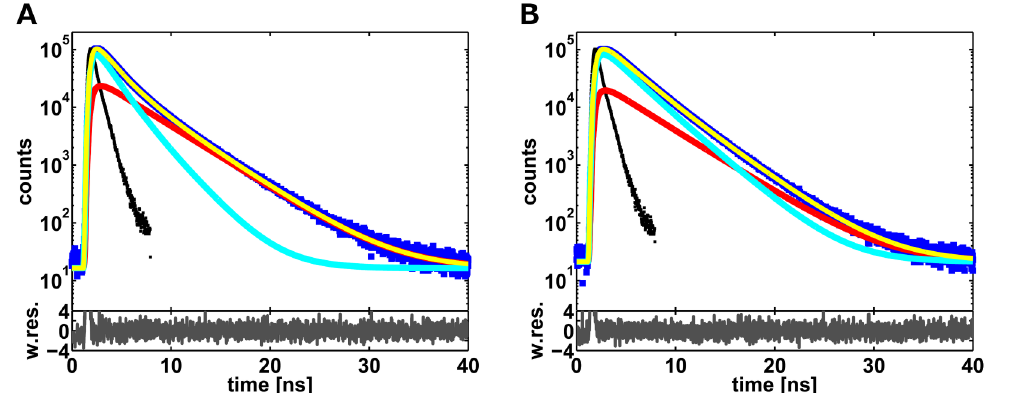
Figure 2. Donor ensemble lifetime decays and fitted model functions for: ( A ) 10 bp DNA and ( B ) 17 bp DNA. The model function, the sum of the donor-only component (red line) and the FRET-quenched decay (cyan line), is shown in yellow. The instrument response function (IRF) is presented in black (FWHM ∼ 544 ps.) The weighted residuals between the experimental data (blue squares) and the model function are shown in gray. For more details about the fits, see Section 3.5. The fitting parameters are reported in Table 1.